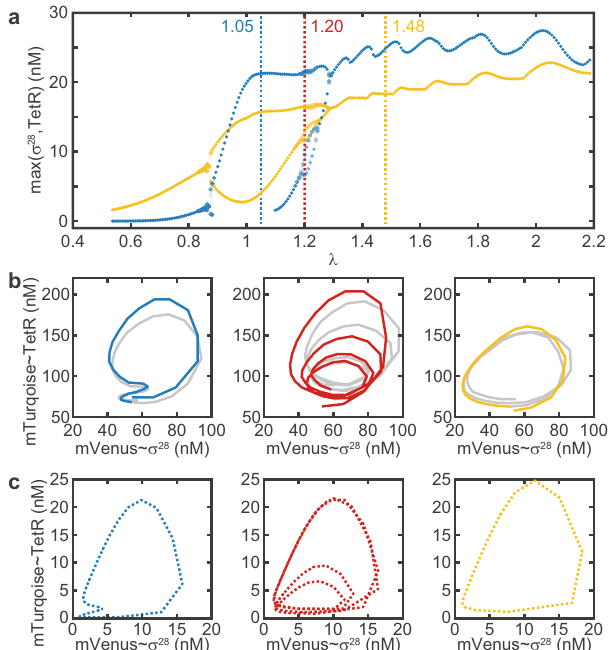
Fig. 6 Bifurcation analysis for varying λ . a Simulated bifurcation diagram showing the maxima for σ 28 (yellow) and TetR (blue). The values of λ that correspond to the experimental data in b and simulations in c are indicated by dashed vertical lines. b Experimental phase portraits exhibit a 2-, 4-, and 1-cycle. A second (third) m -cycle is grayed out for clarity. The 2-cycle is degenerate in the TetR-axis, i.e., the second maximum does not show in the time traces. Data for the 1-cycle and 4-cycle is the same as shown in Figs. 4b and 5. c Simulated phase portraits. Simulations only show endogenous TetR generated by the reaction, rather than total TetR, to match the experimentally observed fl uorescence signals. Parameter values are as in Fig. 2, except α = 5 pMs − 1 , n = 4, T in = 4 h, A in = 50